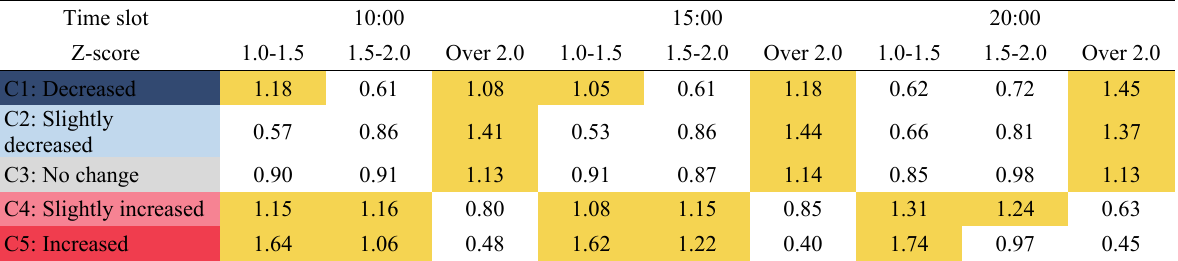
Table 1 . Relative concentration of clusters considering commercial density